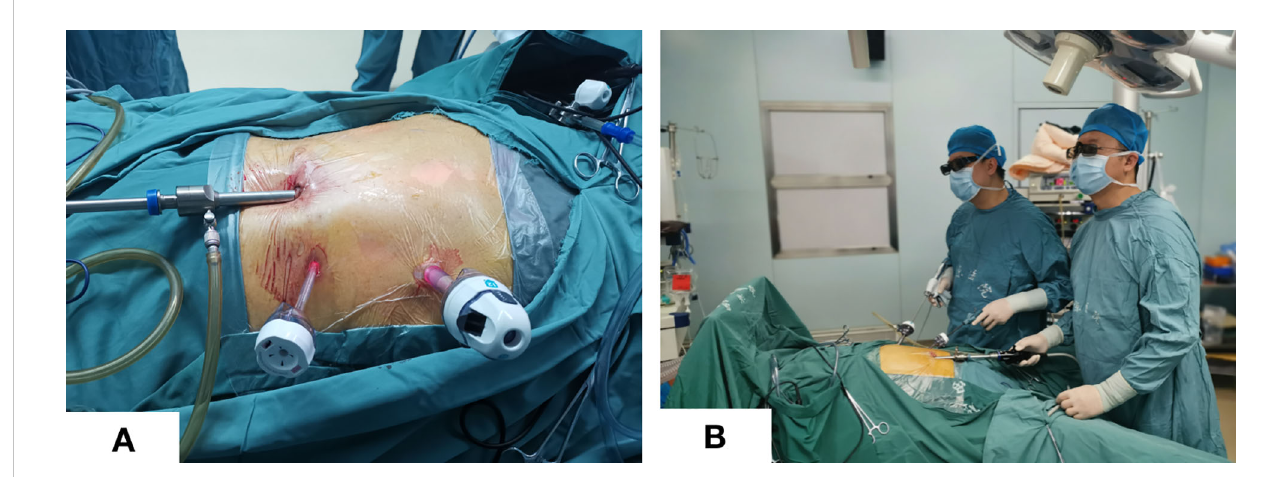
FIGURE 1 Trocar placement and surgeon position. (A) Trocar placement; (B) Standing position of the surgeon and